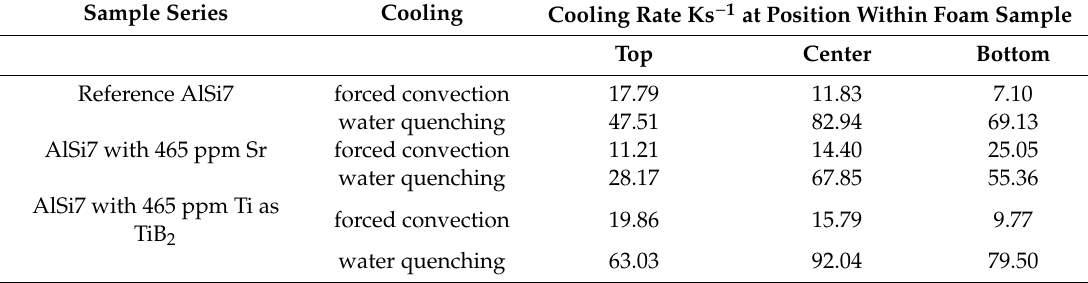
Table 4. Local cooling rates determined for foam samples containing no as well as Sr and Ti as TiB 2 additives (465 ppm each) determined via evaluation of SDAS.